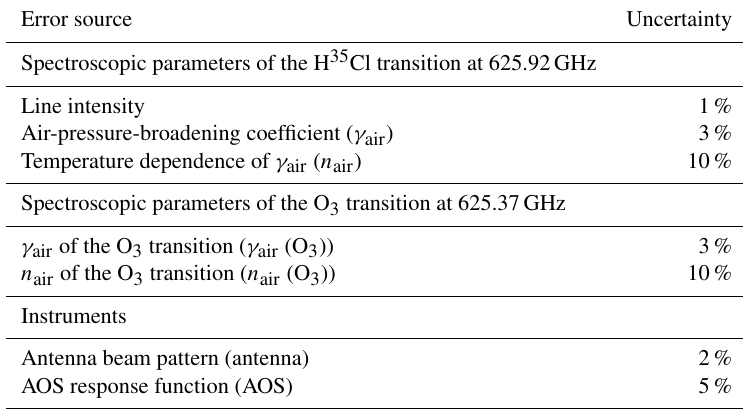
Figure 10. Differences between SMILES and TELIS HCl observations are shown for 24 January 2010. Two of the SMILES observations were taken from closer points, where the latitude, longitude, and SZA were 64.3 ◦ N, 30.6 ◦ E, and 84.6 ◦ SZA and 64.8 ◦ N, 38.2 ◦ E, 86.2 ◦ SZA, respectively. (a) Each profile obtained by SMILES and TELIS instruments; (b) the absolute difference between the SMILES and TELIS profiles calculated using Eq. (3); (c) the relative difference between the SMILES and TELIS profiles calculated using Eq. (4). Table 5. Error sources and their perturbation values for this